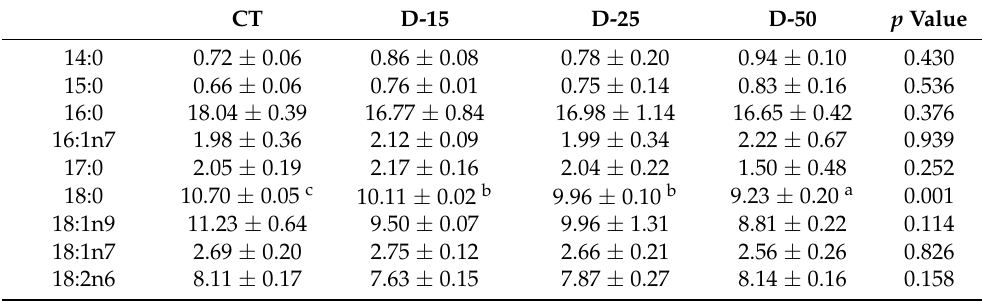
Table 6. Fatty acid composition (% fatty acids) of L. vannamei fed with experimental diets for 70 days.